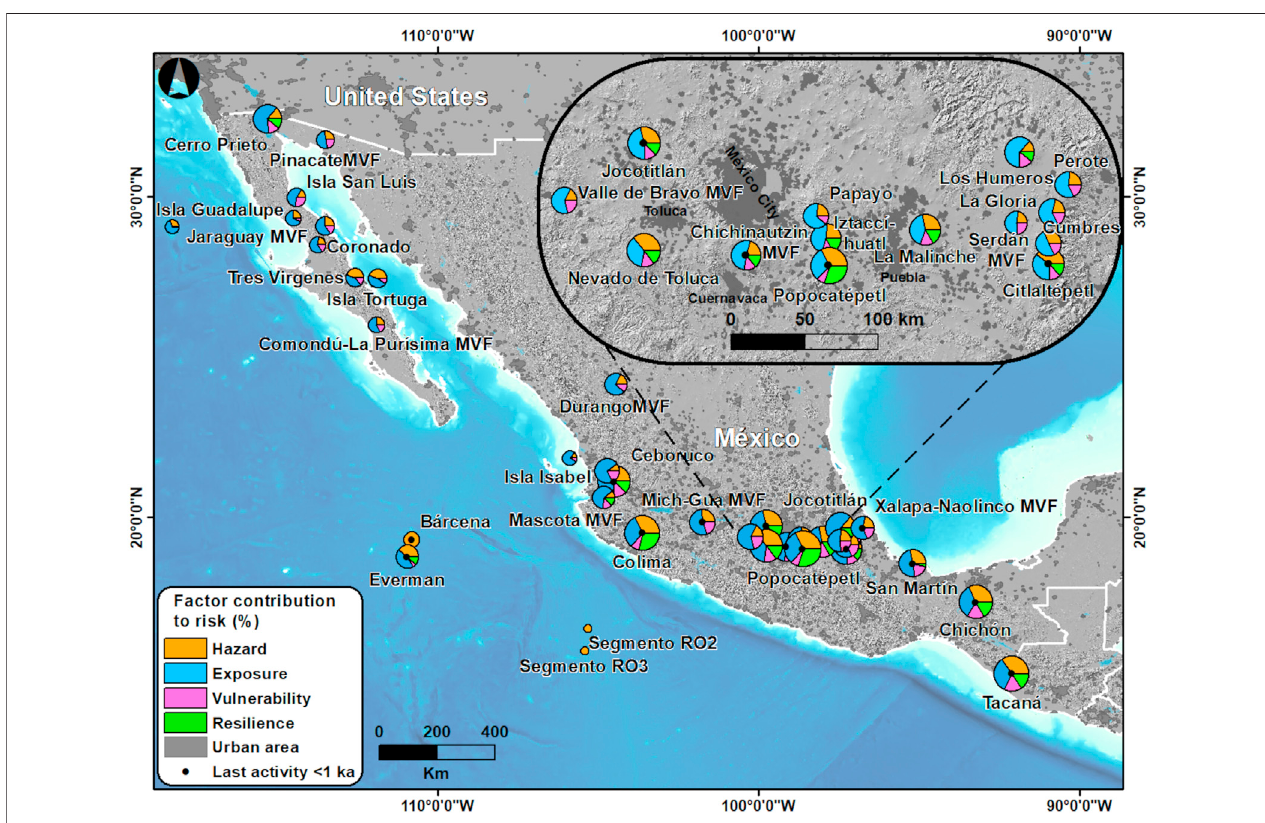
FIGURE4| Contributionoftheindividual riskfactors (hazard,exposure, vulnerability,resilience) fortheMexican volcanoeswitheruption < 10and < 1 ka(volcanoes with eruption < 1 ka are indicated with a black circle).